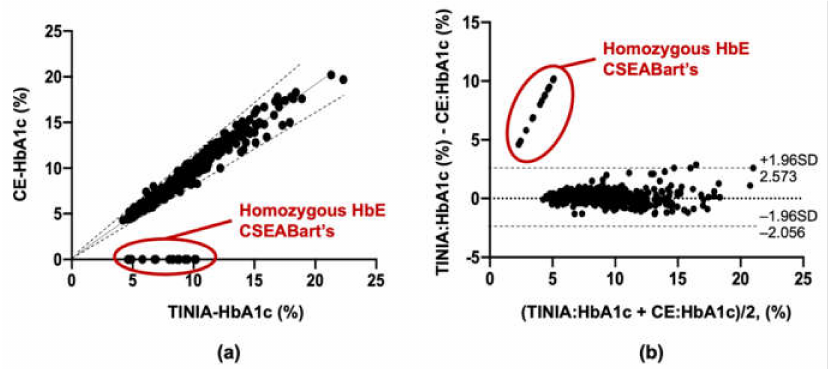
Figure 2. The correlation between the HbA1c level in 845 patients with diabetes measured by capillary electrophoresis (CE) and turbidimetric inhibition immunoassay (TINIA), represented by ( a ) simple linear regression plot and ( b ) Bland–Altman plot. Dotted line represented 95%